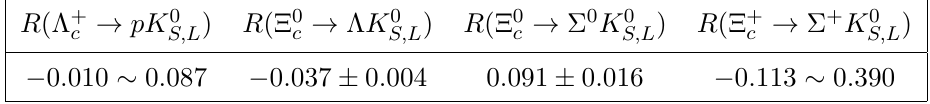
(cid:0) K 0 asymmetries in B c ! B K 0 S L